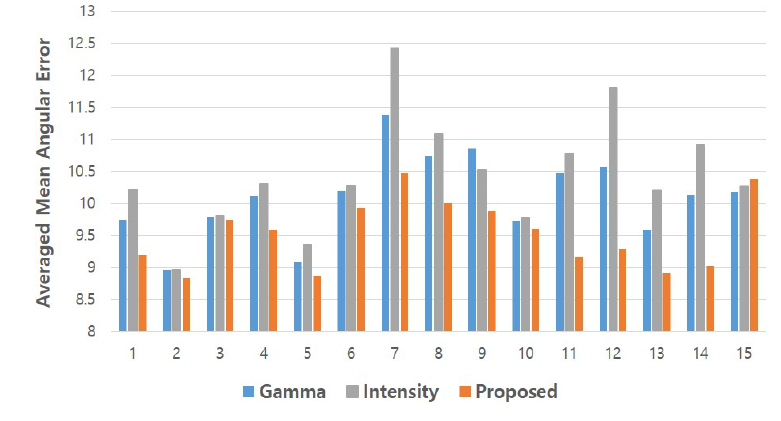
Figure 14. Mean gaze angular error for each subject of the proposed and baseline